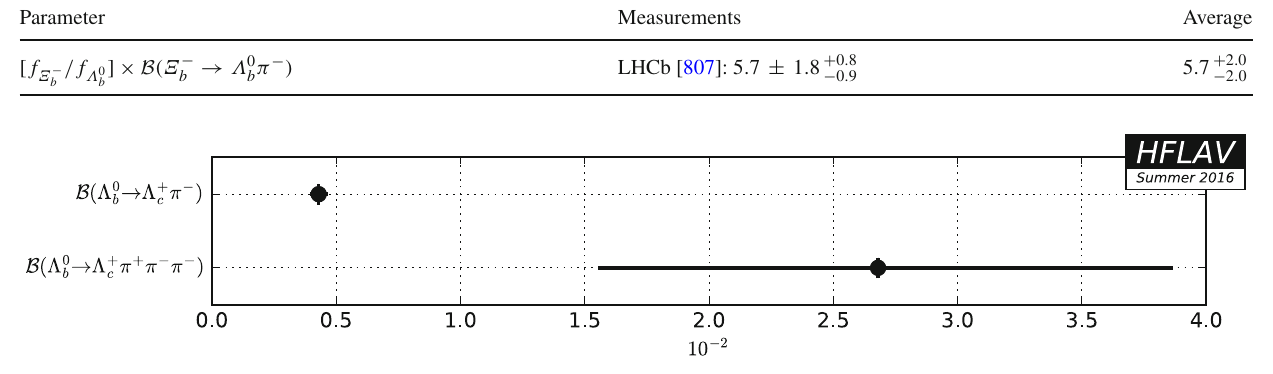
Fig. 172 Summary of the averages from Table 213